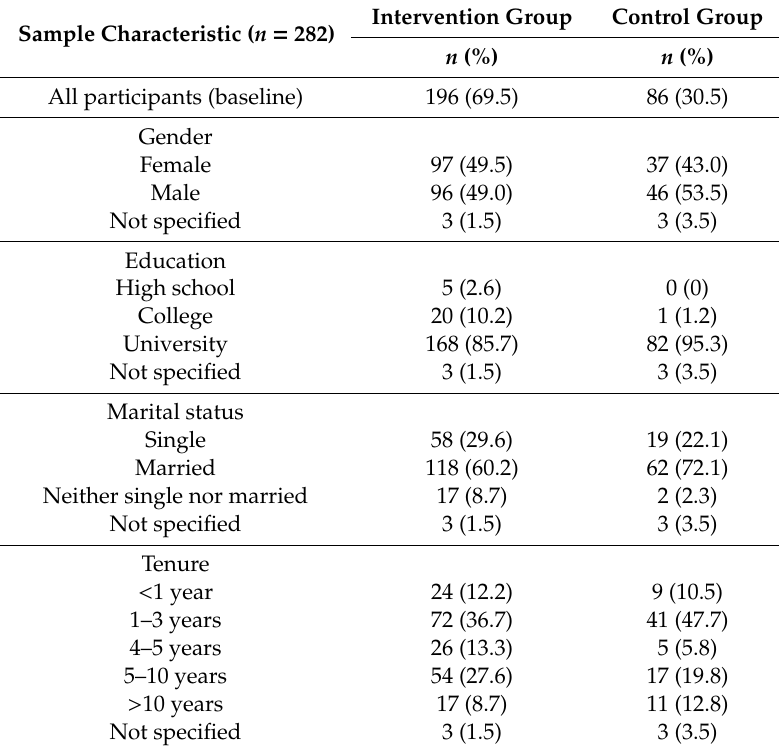
Table 2. Participant characteristics by